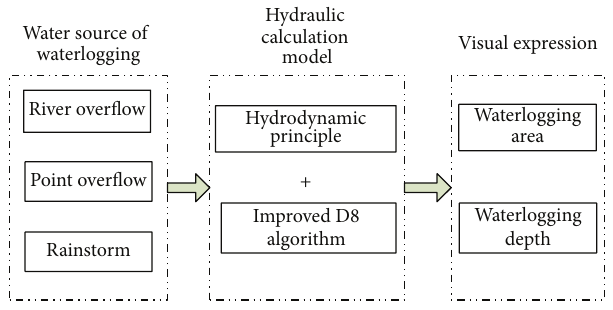
Figure 1: FloodArea model framework concluded by authors.